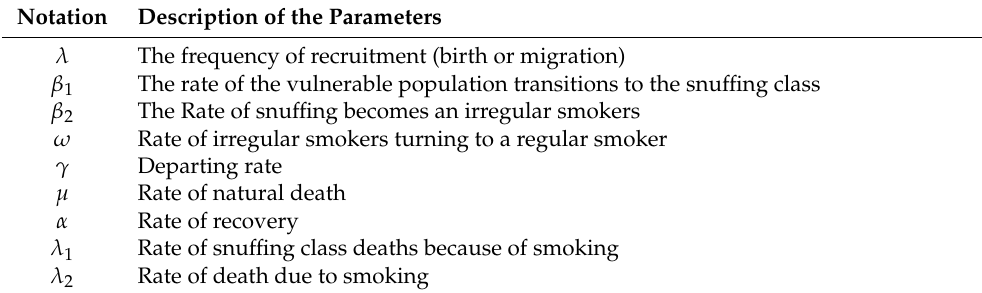
Table 1. Description of the model